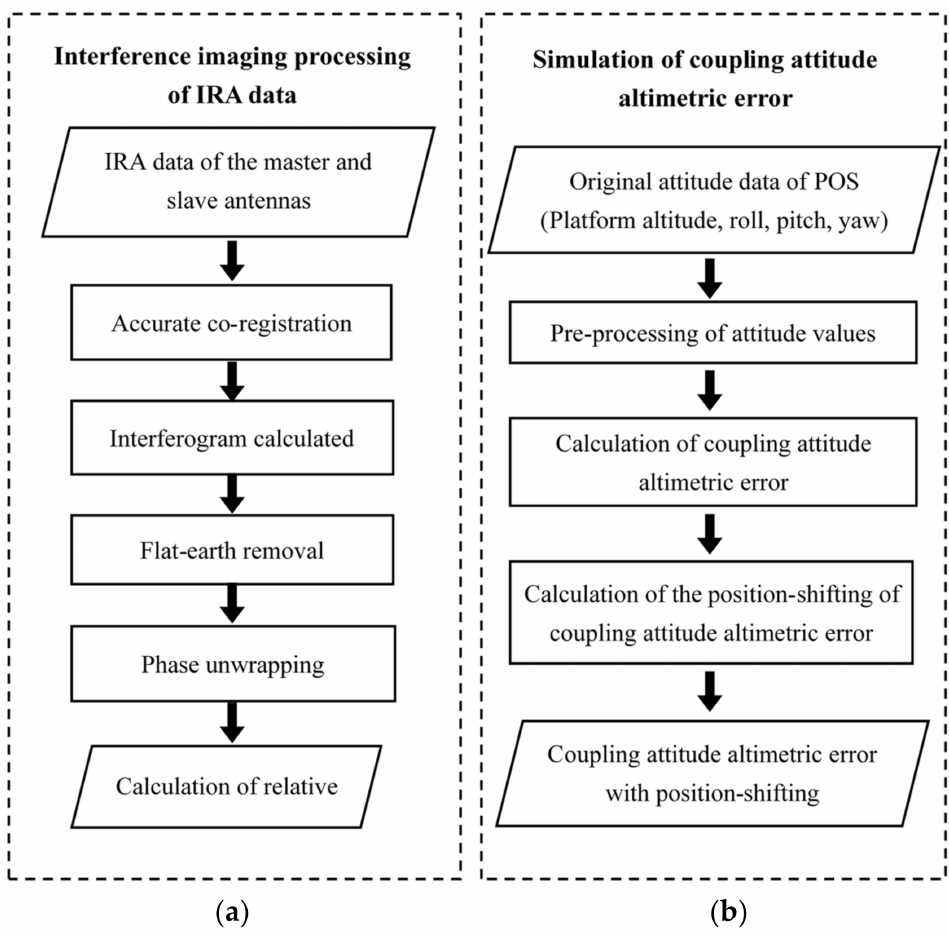
Figure 4. Flowchart. ( a ) Relative SSE imaging processing. ( b ) Coupling attitude altimetric error calculation. The master and slave images received by the airborne IRA during the three experi- ments are shown in Figure